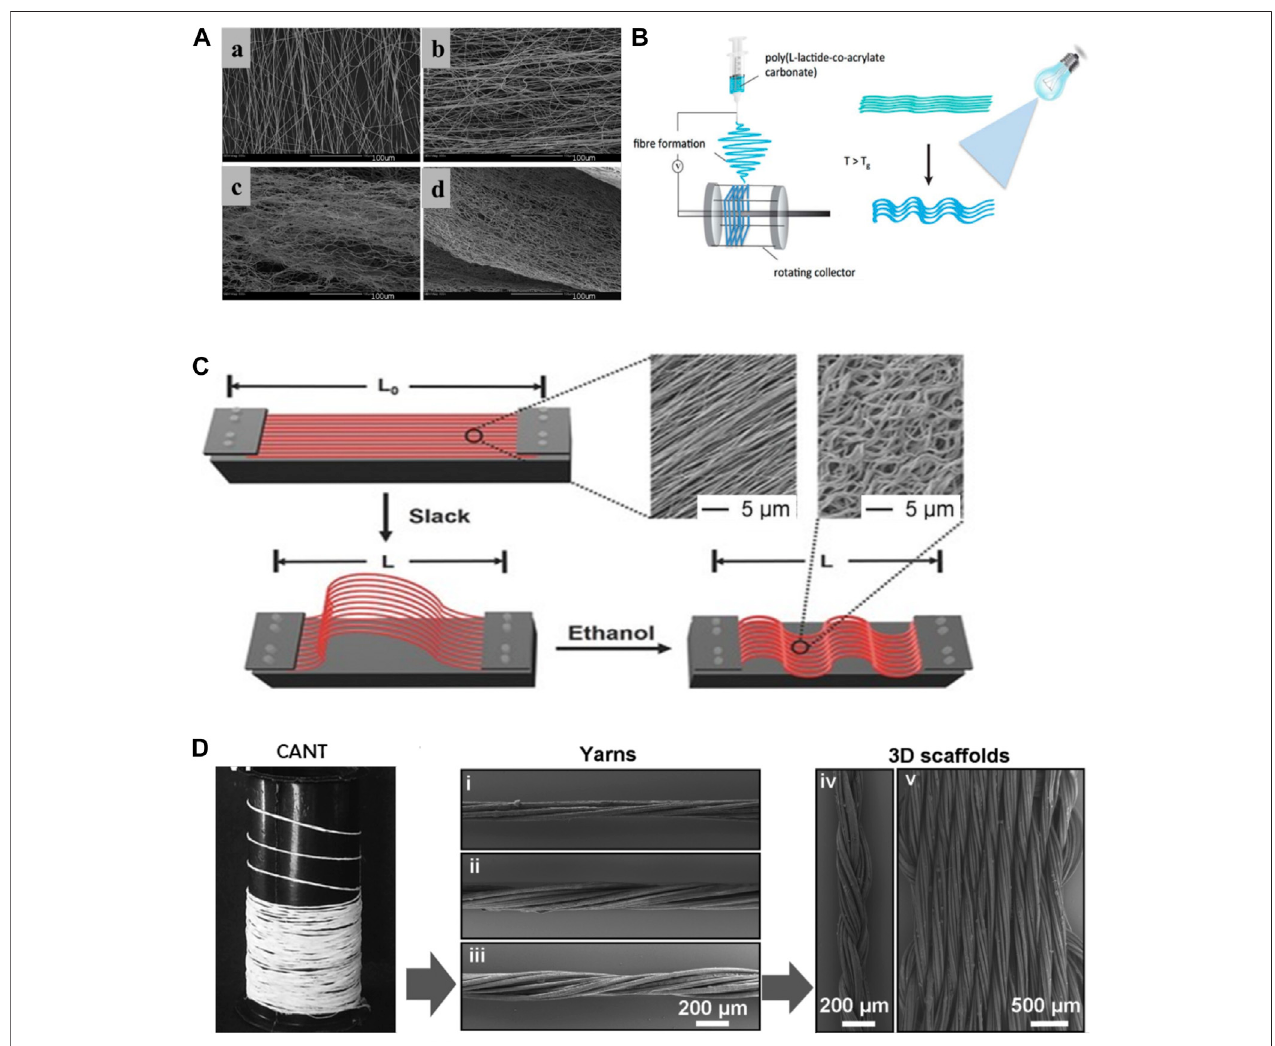
FIGURE 3 | (A) : a)control, b)incubated at 4 ° C, c)incubated at 22 ° C, d)incubated at 37 ° C (Surrao et al., 2010). (B) : fabrications of crimped and cross-linked fi ber scaffolds(Chenetal.,2014). (C) :schematicdiagramofcontrollablecrimp fi ber(Liuetal.,2015). (D) :the3Dstructureofthescaffoldwasobtainedbybraiding(Laranjeira et al.,